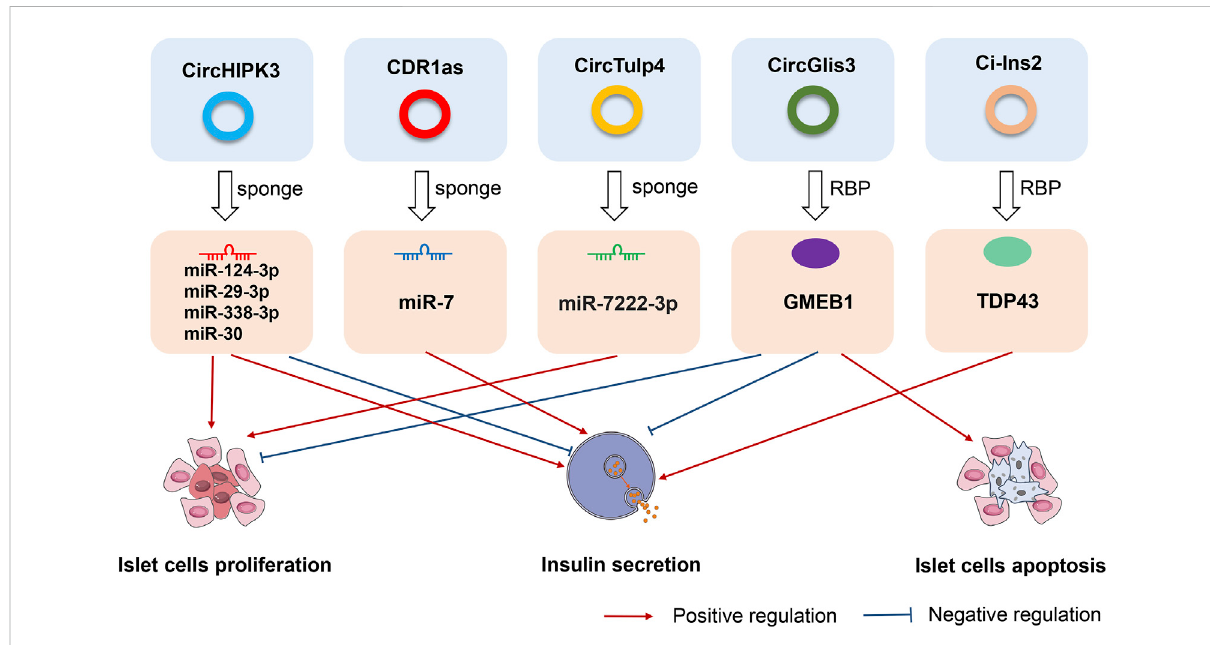
The roles and effects of circRNAs on pancreatic islet β cells. CircHIPK3, CDR1as, circTulp4, circGlis3, and ci-Ins2, are the most representative circRNAs in pancreatic islet β cells. CircHIPK3, CDR1as, and circTulp4 are miRNA sponges that affect cell proliferation, apoptosis, and insulin secretion. CircGlis3 suppresses the proliferation of islet β cells, inhibits insulin secretion, and promotes cell apoptosis by interacting with the RNA- binding protein glucocorticoid modulatory element-binding protein 1 (GMEB1). Ci-Ins2 can promote insulin secretion by interaction with the RNA-binding protein TAR DNA-binding protein 43 kDa (TDP43).